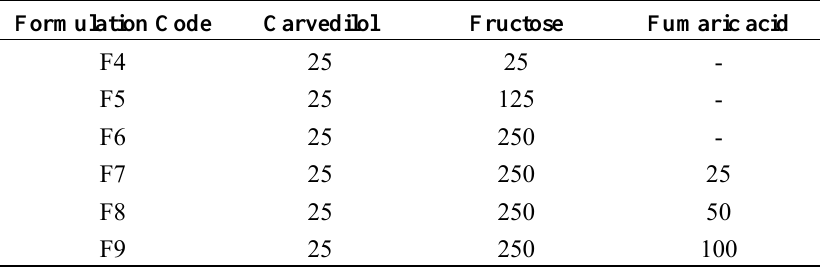
Table 2. Formulation of carvedilol asymmetric membrane